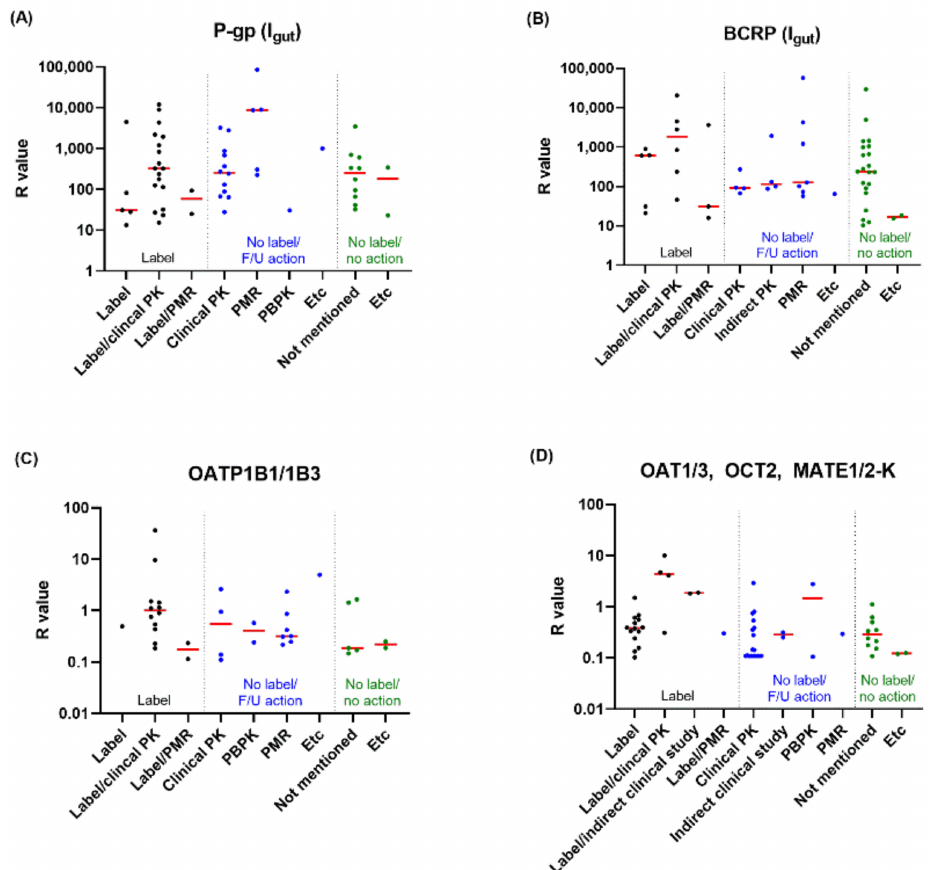
Figure 2. R values of in vitro inhibitor drugs and their follow-up actions (only for drugs with calculated R ≥ cut-off value) for P-gp ( A ); based on I gut ), BCRP ( B ); based on I gut ), OATP1B1/1B3 ( C ), and OAT1/3, OCT2, and MATE1/2-K ( D ). Red lines represent the median values of R in each group. F/U, follow-up; I gut , the concentration of inhibitors in intestinal fluid; PK, pharmacokinetics; PBPK, physiologically based pharmacokinetics; PMR, post-marketing